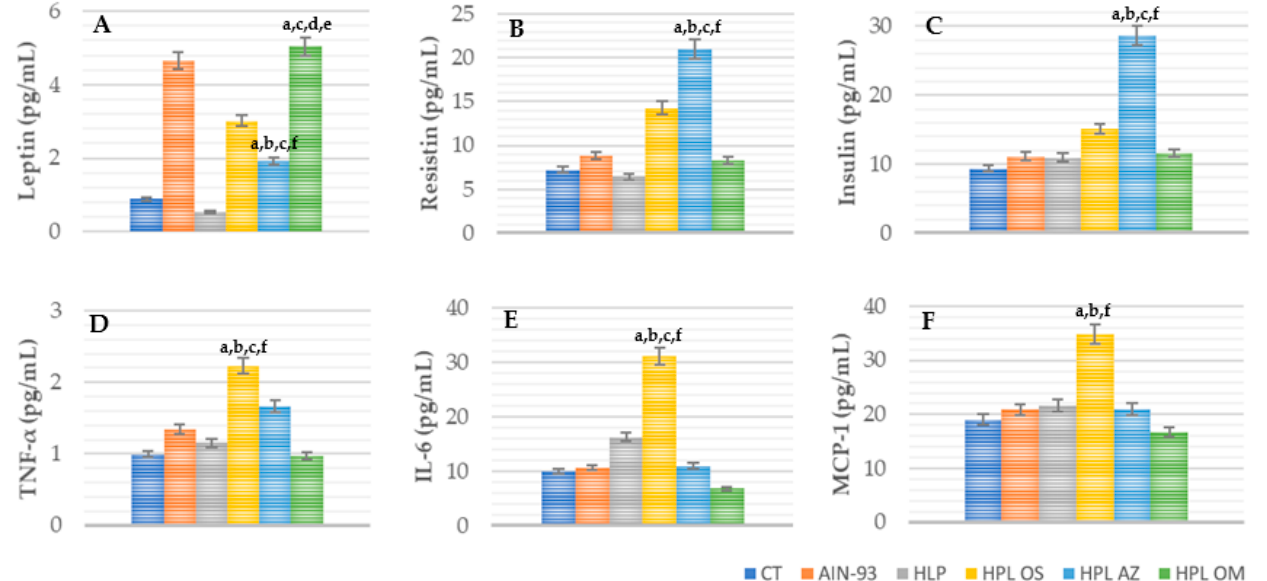
Figure 6. Leptin ( A ), resistin ( B ), insulin ( C ), TNF- α ( D ), IL-6 ( E ), and MCP-1 ( F ) (pg/mL) of animals fed a balanced or high-fat diet supplemented with saline, soybean oil, olive oil, or seed oil of papaya ( Carica papaya Linn). Values expressed as mean ± standard deviation. The letters indicate statistical difference as follows: a compared to CT; b compared to AIN 93; c compared to HPL; d compared to HPL OS; e compared to HPL AZ; f compared to HPL OM. p < 0.001. n = 6–11. ANOVA followed by Tukey post test.